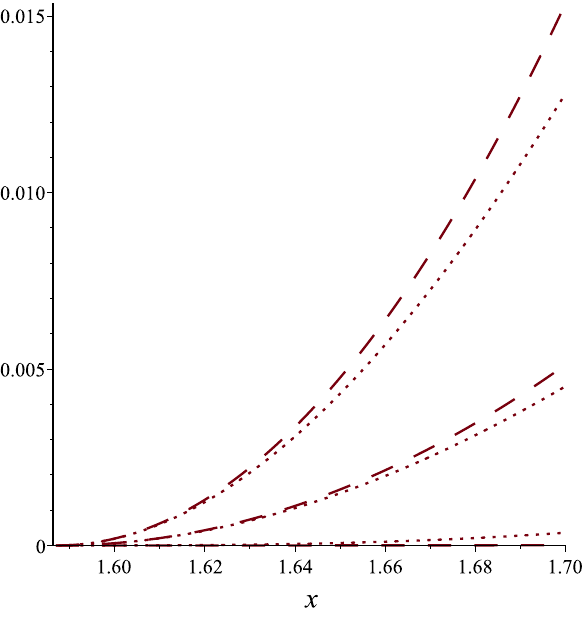
Fig. 5 Comparisonoftheapproximateform(22)oftheeffectivepoten- tial (dashed lines) close to the event horizon in the extreme case with the exact form of U ef f (dotted lines) given by (9) for different values of the angular momentum ( (cid:3) = 0 bottom, (cid:3) = 1 middle, (cid:3) = 2 upper curves). The plot has been generated by expressing (22) in terms of the variable x with the help of